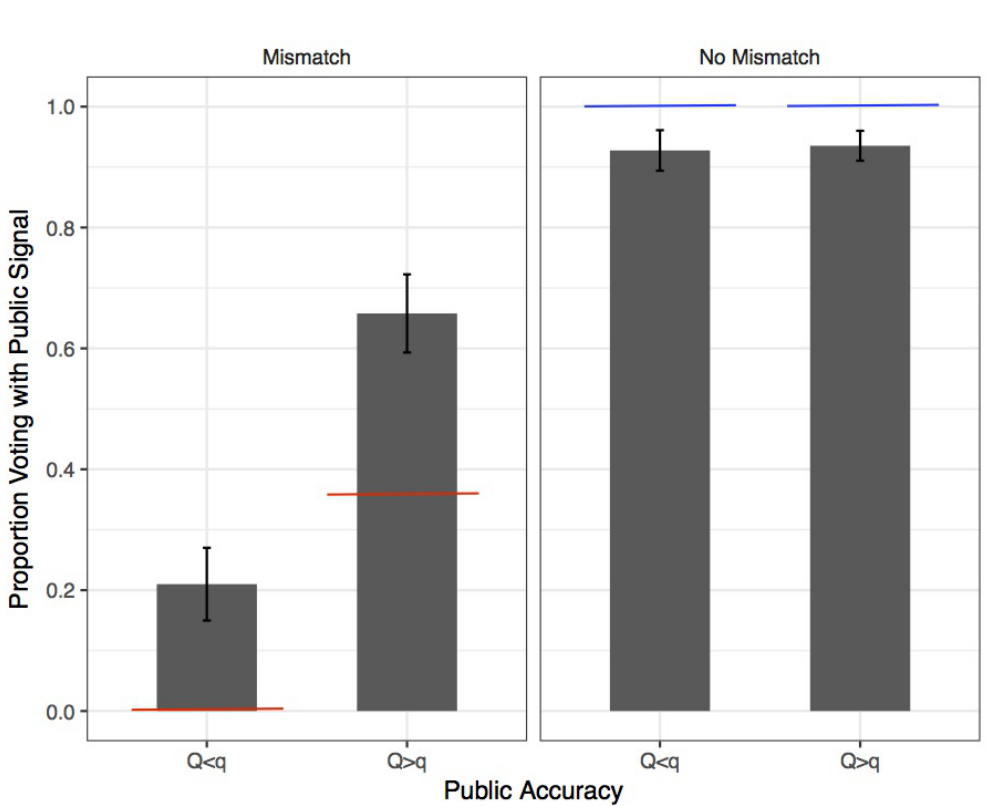
Figure 1. Responsiveness of vote to signals’ precision : Average fraction of votes with public signal in sessions with committee decisions, and associated 95% confidence intervals. Standard errors are clustered at the individual level. In the left plot, the public signal and the private signal disagree, and red lines represent the symmetric responsive equilibrium prediction for µ , the probability of voting for the public signal under mismatch. In the right plot, the signals agree, and blue lines represent the unique optimal decision when the two signals